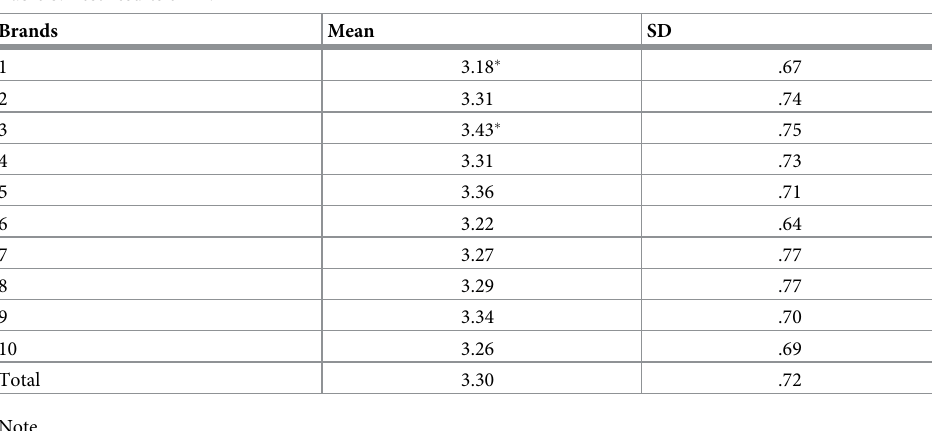
Table 8. Test results of